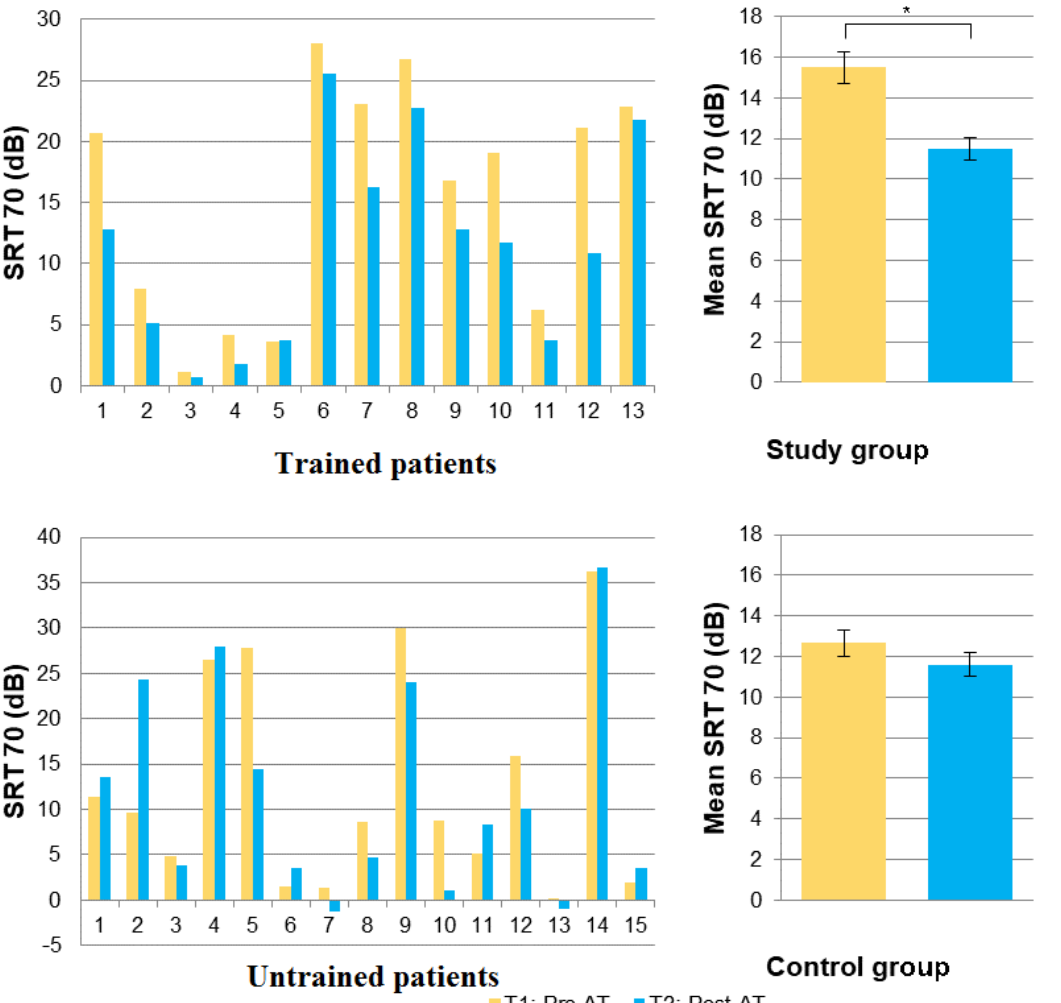
Figure 3. Changes over time in signal-to-noise ratio (dB) at a 70% speech reception threshold. Individual results are shown on the left and mean group results on the right in the study group ( top panel ) and control group ( bottom panel ); testing at enrollment (yellow) and at 5 weeks (blue). The difference is significant only in the study group (noted